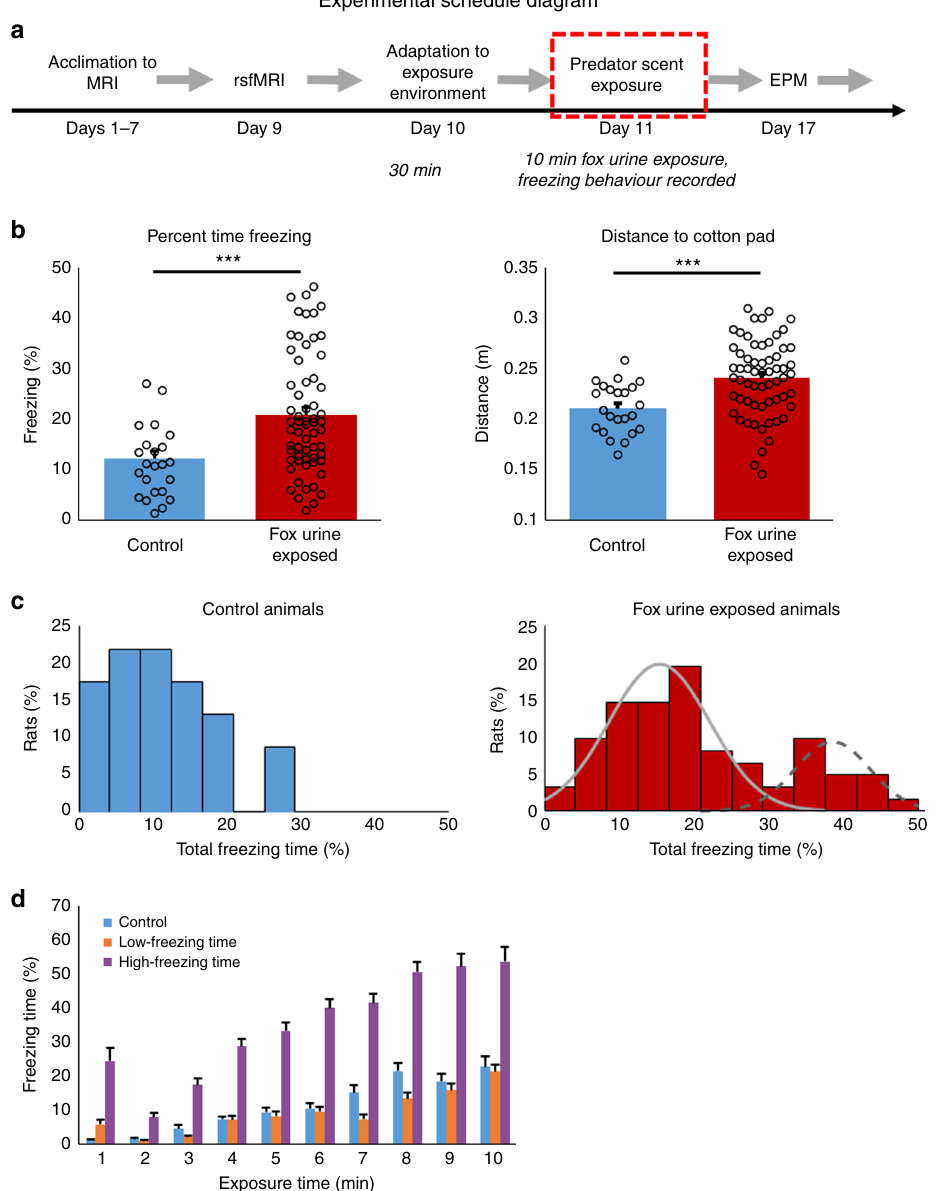
Fig. 1 Freezing behavior during exposure. Freezing time during the 10-min exposure session in control ( n = 23) and fox-urine exposed ( n = 62) groups. a Diagram of experimental schedule. b Fox-urine exposed animals showed a signi fi cantly longer freezing time (left, p < 0.0005, in percentage) and greater mean distance (right, p < 0.0007, in meters) from the cotton pad than controls. c The distributions of individual animals ’ freezing time in the control group (left) and the exposed group (right) displayed as probability histograms. The freezing time distribution in exposed animals was fi t to a Gaussian mixture model, which demonstrated a bimodal distribution. d Freezing time each min plotted as a function of time in low-freezing ( n = 21), high-freezing ( n = 21) and control animals during fox-urine exposure. The high-freezing animals displayed higher freezing phenotype during the fi rst minute of exposure, with a signi fi cantly longer freezing time than both low-freezing and control animals from the 1st minute through the 10th minute ( p < 0.005 for each minute of exposure). Bars indicate s.e.m. Source data of Fig. 1b – d are provided as a Source Data fi time (One-way ANOVA, F Group×Zone (2, 62) = 0.24, p = 0.788, sample. Relative to high-freezing animals, low-freezing animals showed even more leftward bias. The normalized freezing time Supplementary Fig. 2) or location distribution (the cage was was signi fi cantly less in the zone 24 cm away from the pad (Two- divided into three even-size zones, Two-way ANOVA, way Repeated ANOVA, F Group×Zone (22, 682) = 3.00, p = F Group×Zone (4, 186) = 1.28, p = 0.28). In addition, the three 0.000006; Tukey-Kramer post-hoc test, low- vs. high-freezing at groups exhibited no differences in total distance traveled (one- 24 cm: p = 0.04), indicating that low-freezing animals were way ANOVA, F (2,62) = 0.082, p = 0.92), maximum speed (one- somewhat more avoidant than high-freezing animals. This can way ANOVA, F (2,62) = 0.0085, p = 0.99), or average speed while also be seen in the heat plots of Fig. 2a. mobile (one-way ANOVA, F (2,62) = 0.21, p = 0.81) during the Prior to predator scent exposure during the habituation period, pre-exposure period, further con fi rming consistent mobility the three groups showed no signi fi cant differences in freezing among these animals.